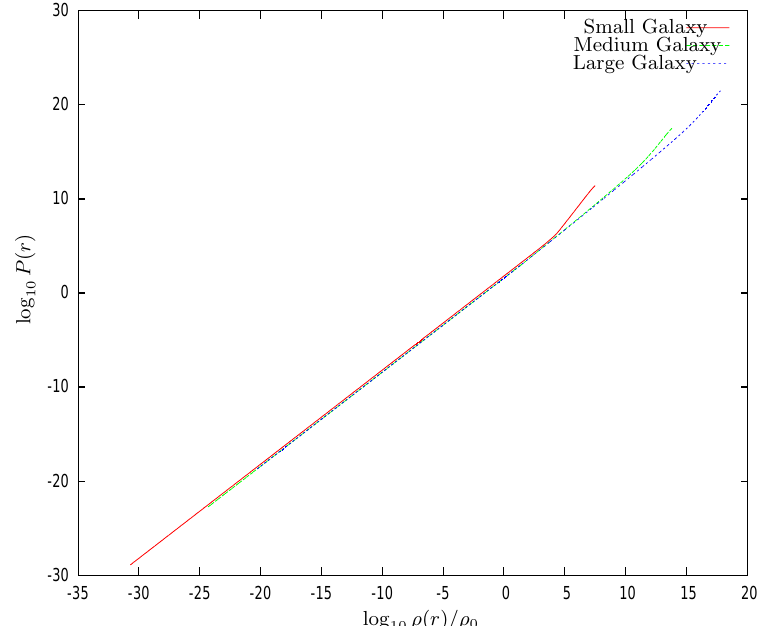
FIG. 13: The logarithm of the local pressure log P ( r ) vs. log ( r/r h ) for the three galaxy solutions with central SMBH. Notice ( r / r h ) for the three galaxy solutions P ( r ) vs. log Figure 13. The logarithm of the local pressure log 10 10 10 10 the huge values of P ( r ) in the quantum (high density) region r < r A and its sharp decrease entering the classical (dilute) region with central SMBH. Notice the huge values of P ( r ) in the quantum (high density) region r < r A and r > r A . its sharp decrease entering the classical (dilute) region r > r A .